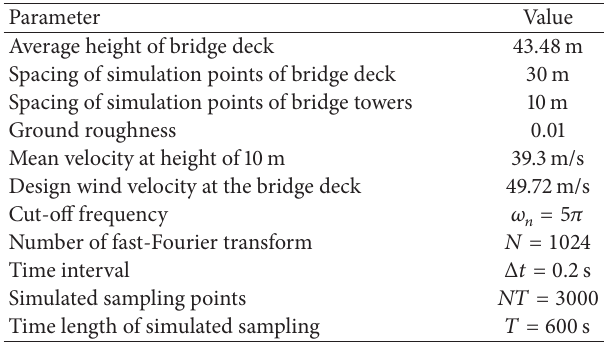
Table 3: Parameters for the bridge’s input condition caused by